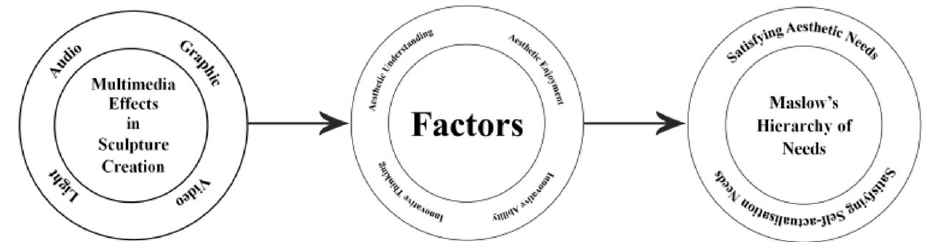
Figure 2. The preliminary framework of multimedia effects in sculpture creation with Maslow’s hierarchy of hierarchy of needs.